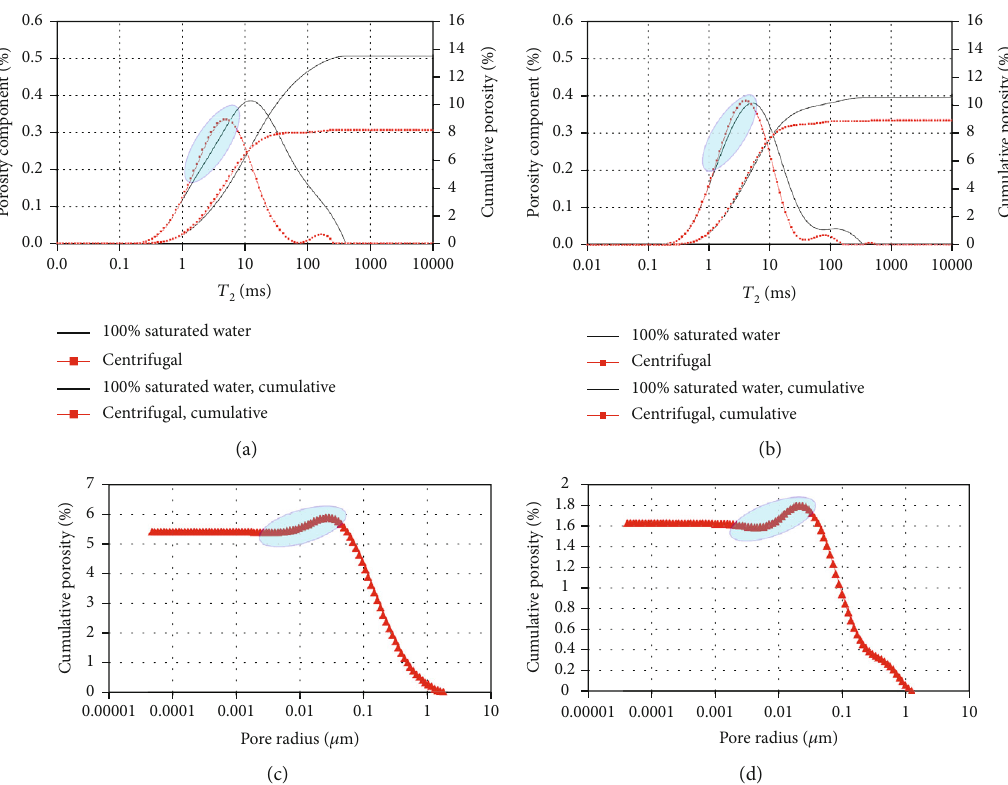
Figure 8: Images showing NMR experimental system errors: (a) B64-38, T accumulation area; (d) B65-8, negative accumulation